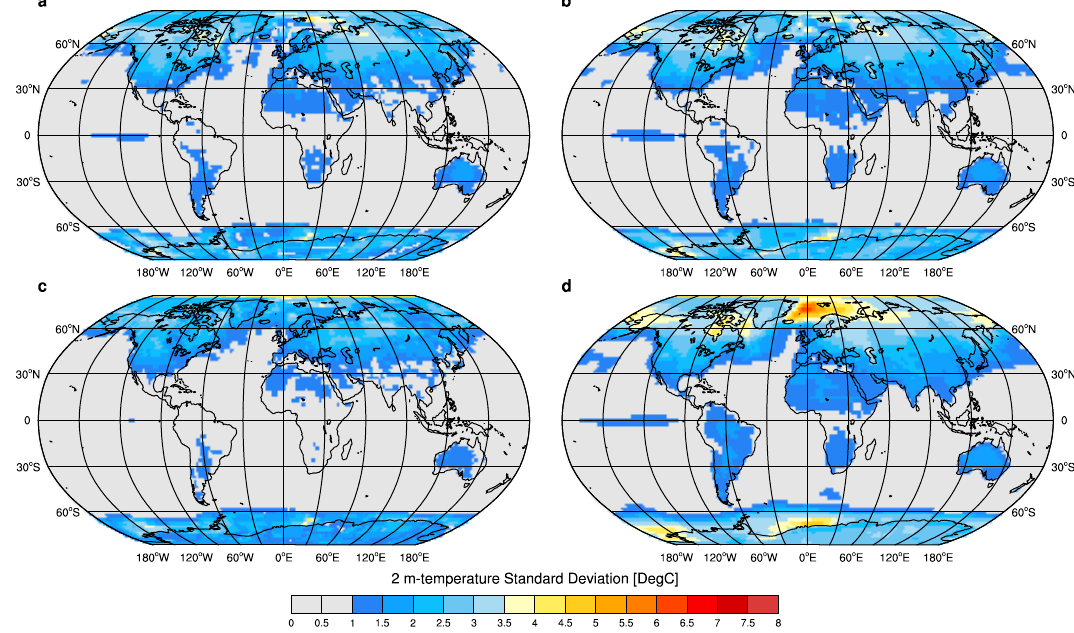
Figure 5. The 2m-temperature uncertainty during the 10-year validation period for three forecasting methods, (a) EWA, (b) EGA, and (c) LAA, and (d) the simple average. The uncertainties of the EWA and LAA are smaller than those of the EGA; however, the predictions of the EGA are better (see the text for a more detailed explanation). All the forecasters yield smaller uncertainties than the simple average. The uncertainties, corresponding to the SLA forecasting schemes, are significantly reduced in regions where the uncertainties are larger, such as toward the poles and over South America and